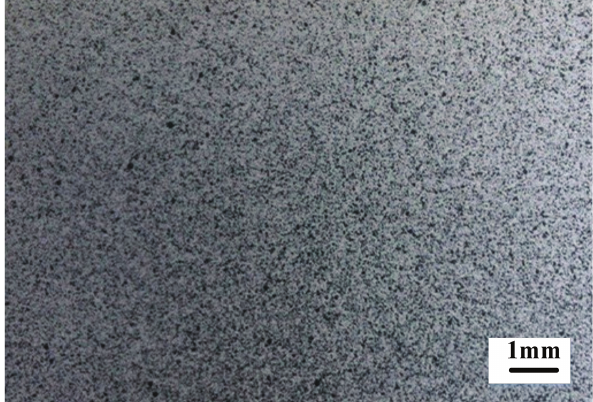
Figure 2: Random black-on-white speckle patterns sprayed on the surfaces of all